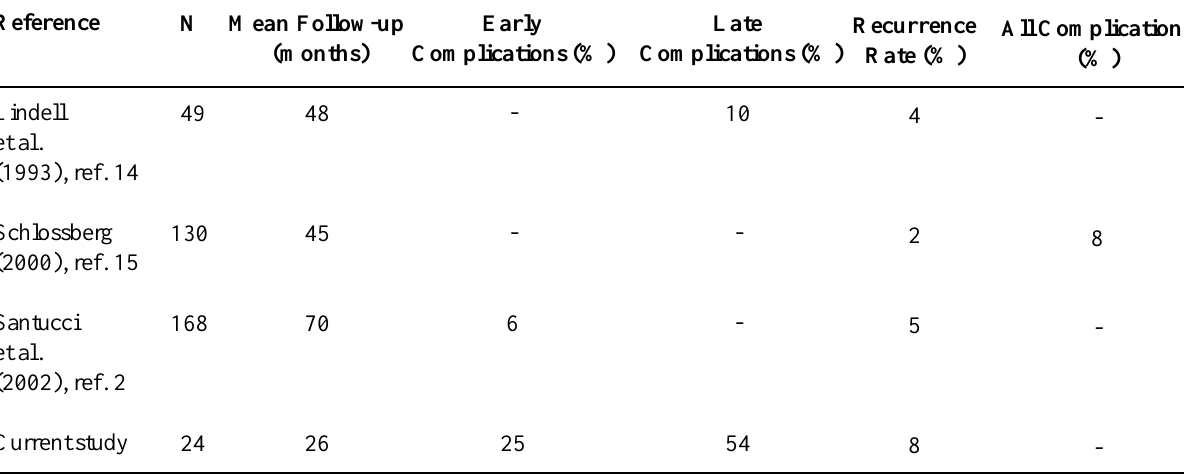
Table 8 – Reported complications after anterior anastomotic urethroplasty.